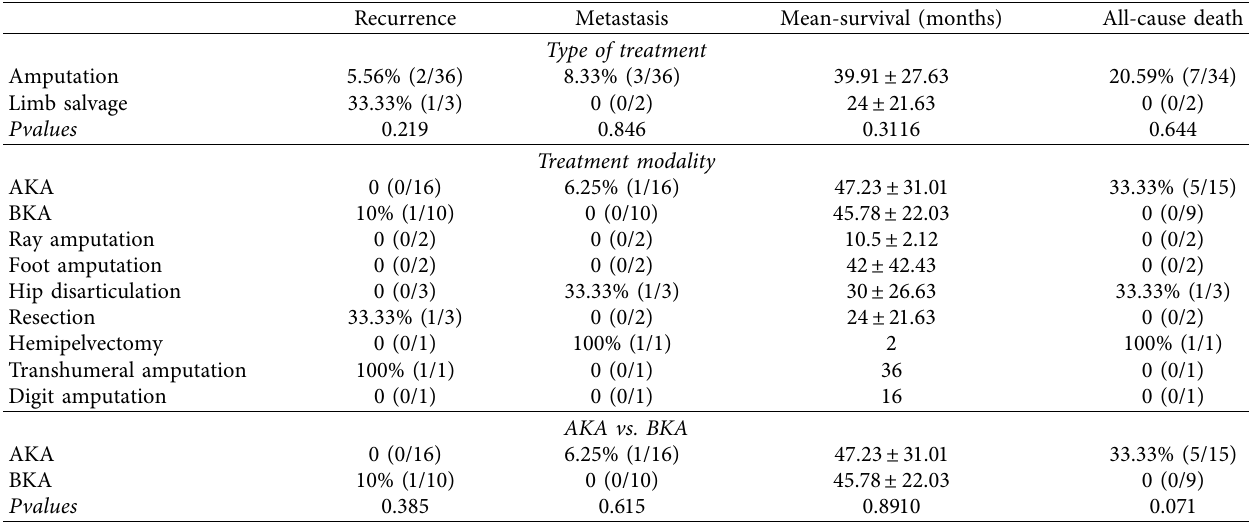
Table 4: Treatment modalities and associated risk of recurrence, metastasis, and/or all-cause death. AKA: above-the-knee amputation, BKA: below-the-knee amputation.